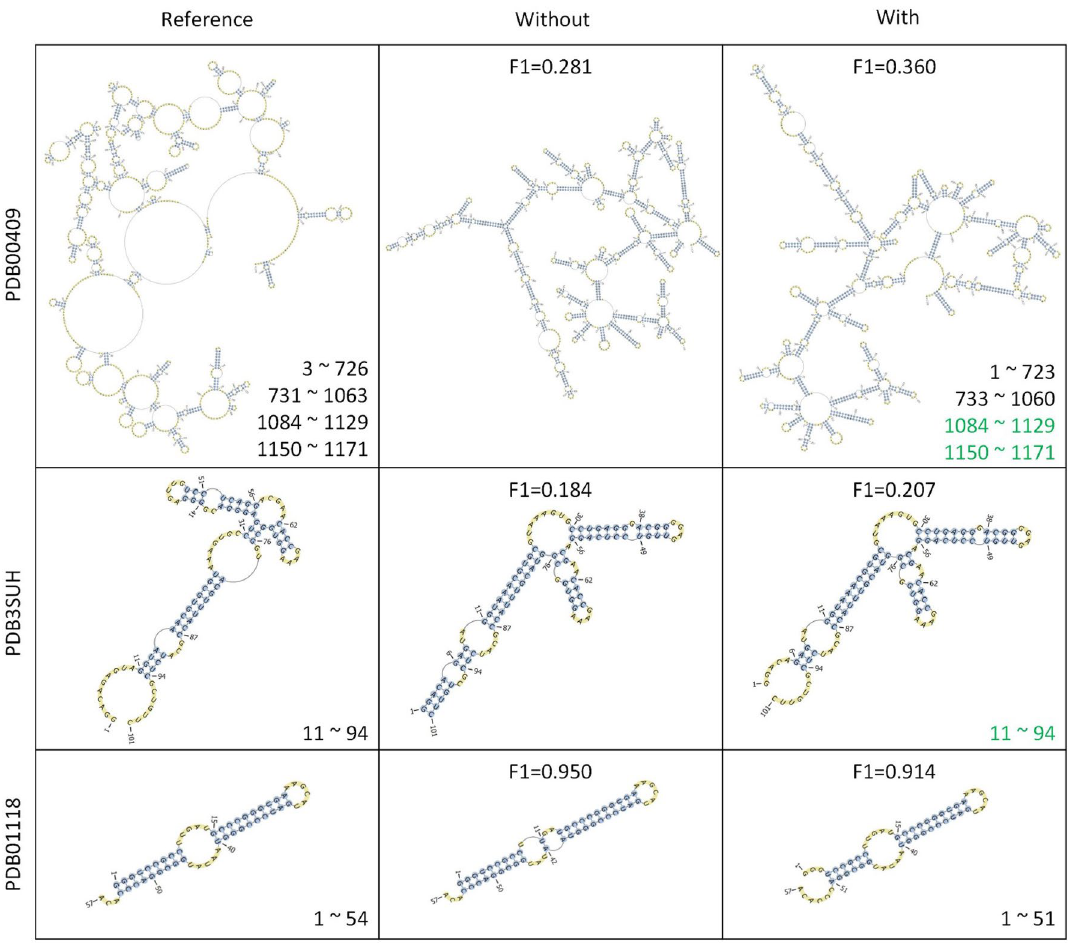
Figure 11. Comparison of the RNA structure predicted using prediction method with or without RNA-par. Structures in the first column were drew with the reference structures of the corresponding RNAs; structures in the second column were drew with the structures directly predicted by RNA secondary prediction methods (RNAfold for PDB00409 and PDB3SUH, SPOT-RNA for PDB01118); structures in the third column were drew with the ensembled structures of i-fragments (structures were predicted by RNA secondary structure prediction methods, and i-fragments were obtained by RNA-par). The numbers in the bottom right corner of the cells in first and third columns are the regions of i-fragments identified by RNA-par, of which the numbers in green are correct predictions and those in black are incorrect predictions. The structure plots were drew by RNApdbee 2.0 38 , (http:// rnapd bee. cs. put. poznan.